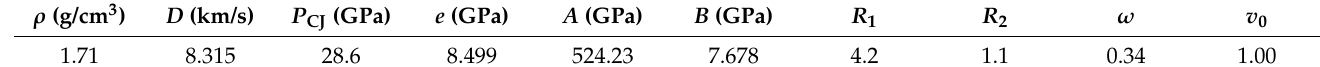
Table 2. Johnson – Cook strength model parameters of the reactive liner and #45 steel.